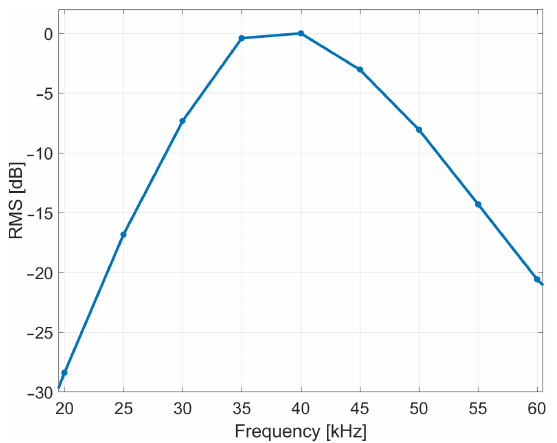
Figure 3. The surface mount transducers frequency response that was measured using the micro- phone model that was used in the